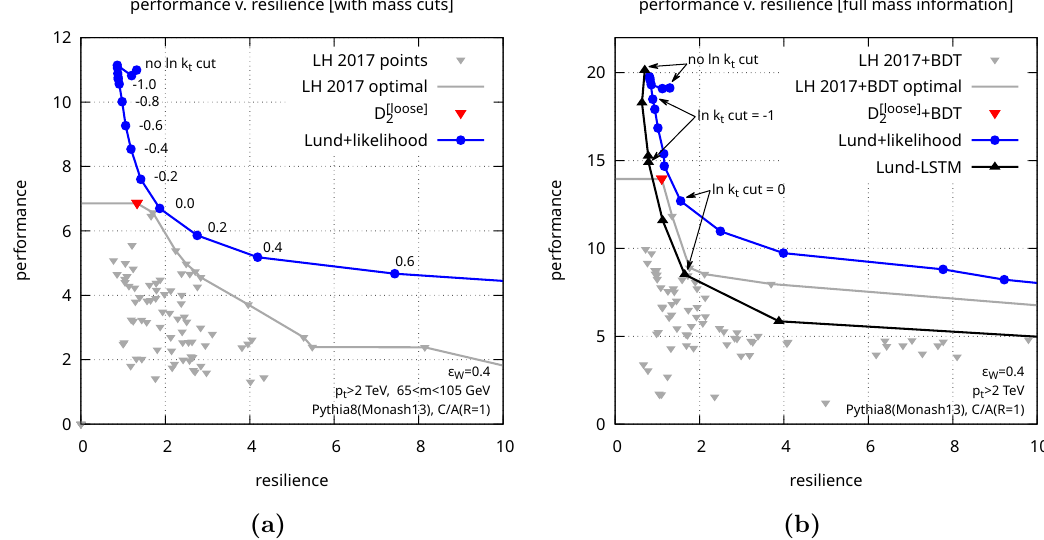
p Figure 11. Plots of performance ( (cid:15) W = (cid:15) QCD ), for (cid:12)xed (hadron+MPI) signal e(cid:14)ciency (cid:15) W = 0 : 4, versus resilience to non-perturbative e(cid:11)ects, ( (cid:16) of eq. (3.6)). Grey triangles (and the red one) correspond to the full range of shape observables studied in the LH 2017 study [80]. The blue circles and black triangles correspond to the Lund-likelihood and Lund-LSTM methods respectively, with each point along a line corresponding to di(cid:11)erent lower cuts on the Lund-plane ln k t = GeV value, below which declusterings are ignored (i.e. not passed to the LSTM or likelihood method; training is repeated for each di(cid:11)erent k t cut). In (a) the shape observables are used together with a cut on a mass variable, 65 < m < 105 GeV (the mass may be groomed, or ungroomed, depending on the point); for the Lund likelihood, eq. (3.1) is evaluated with a single (groomed) mass bin, covering the same mass range as for the shapes, plus an out(cid:13)ow mass bin. In (b) shape variables are combined with the full particle-level resolution mass information through a boosted decision tree (BDT) and the cut that de(cid:12)nes (cid:15) W = 0 : 4 is placed on the BDT output; for the Lund-likelihood and LSTM methods, full resolution Lund-plane information is used (including the mass for the likelihood method). For the Lund+likelihood method, the values of the ln k t cuts are the same as for (a), i.e. spaced every 0.2 units of ln k t . For the Lund+LSTM curves points are separated by 0.5 units of ln k t